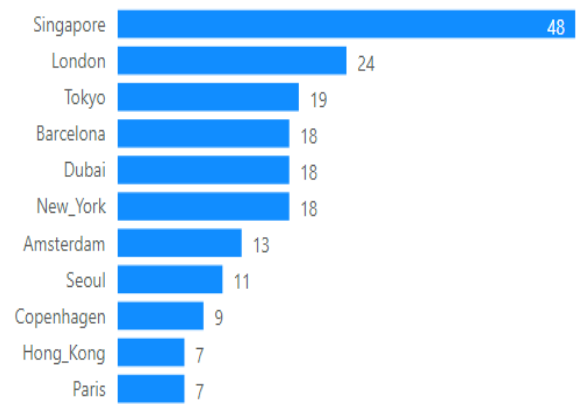
Figure 6. Top 10 Smartest